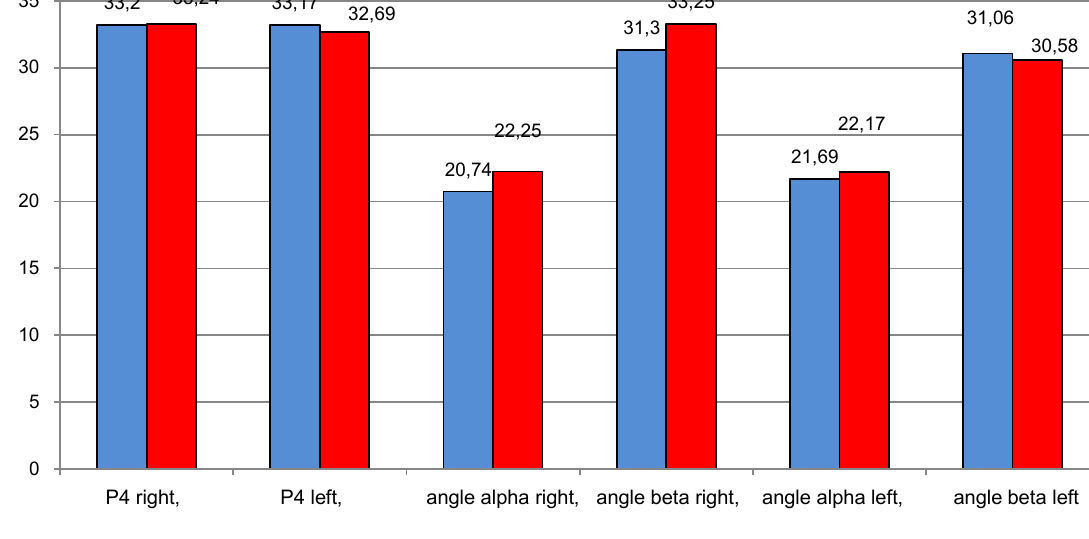
Fig.1. Correlation of main indicators of feet arches of highly qualified female